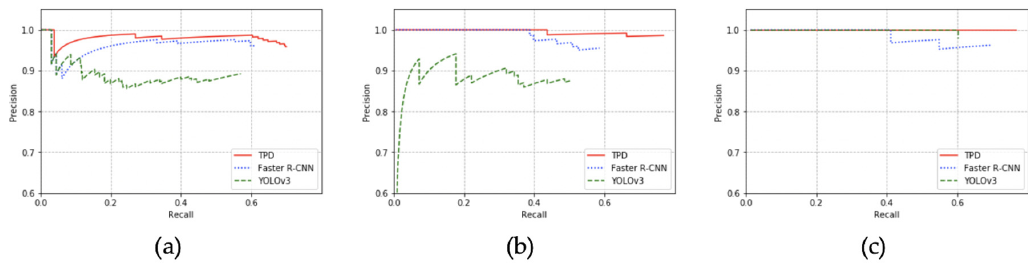
Figure 9. PR (precision-recall) curves of detection systems in three testing datasets. Evaluation results of testing datasets 3, 4, and 5 are shown in ( a – c ), respectively. TPD (tobacco plant detector) is presented as red solid lines, faster R-CNN (regions with CNN features) is presented as dotted blue lines, and YOLOv3 (you only look once v3) is presented as green dashed lines.